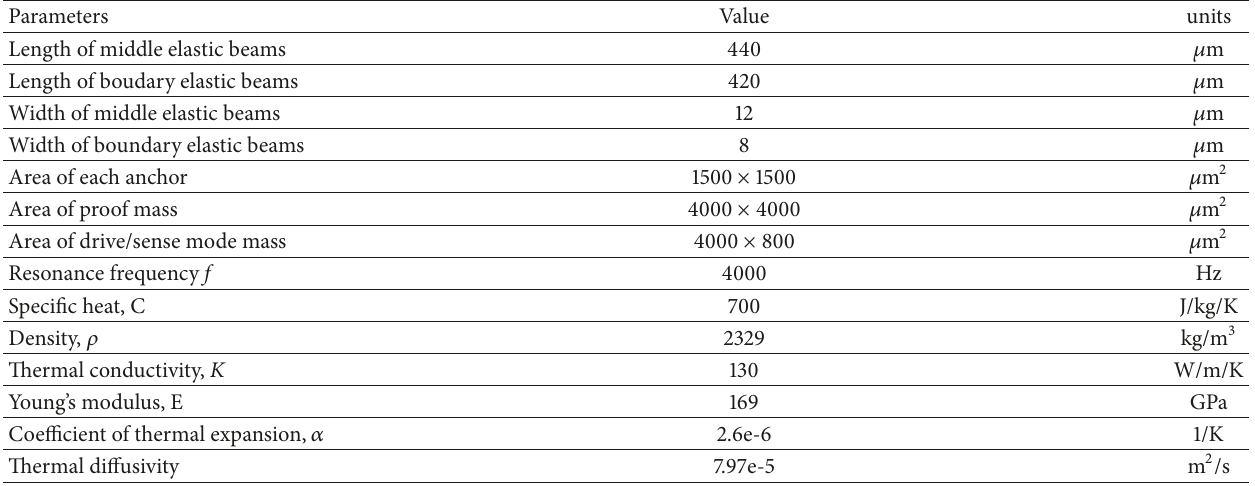
Table 1: GEOMETRICAL PARAMETER AND MATERIAL PROPERTIES.